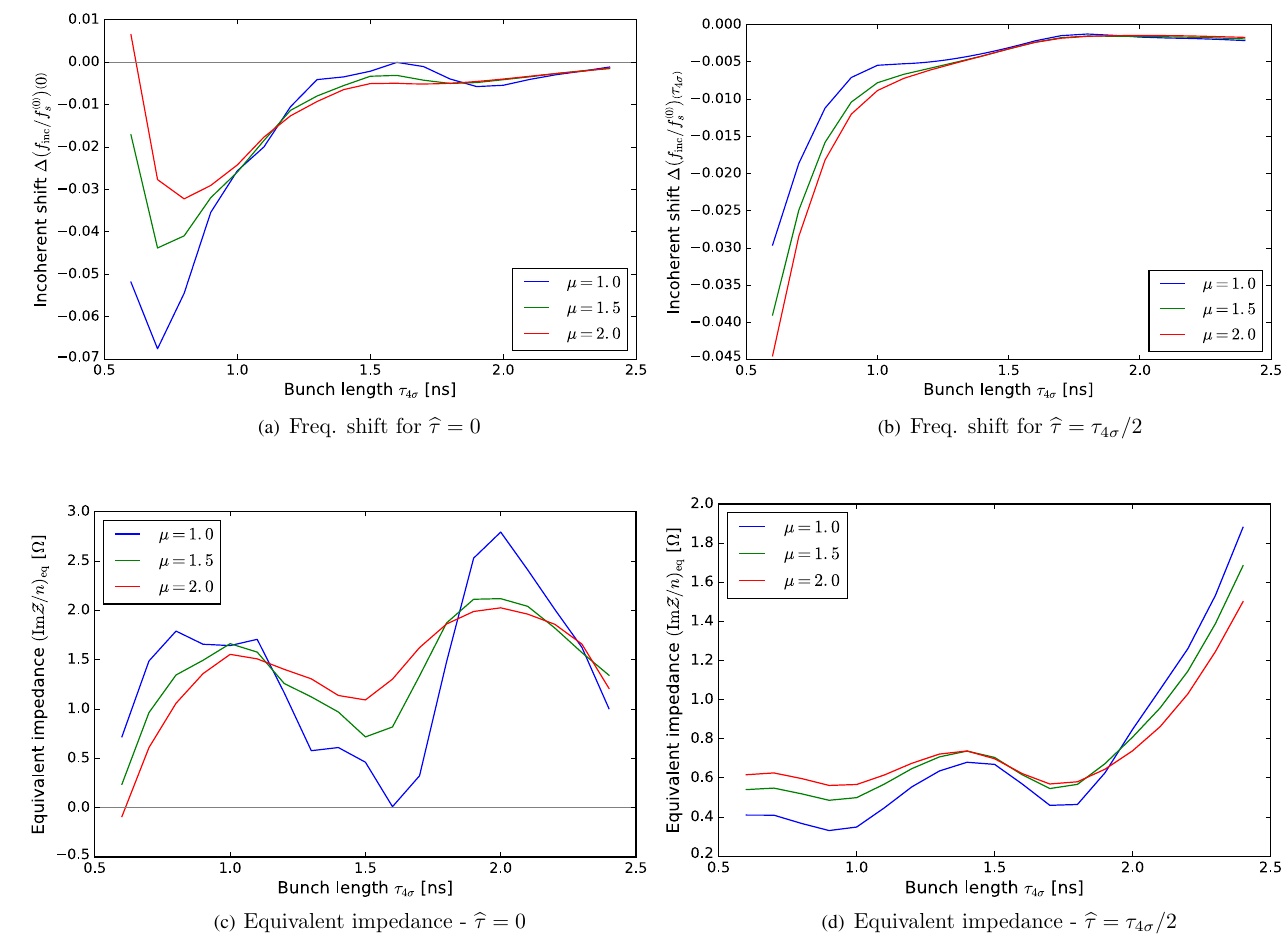
FIG. 8. The incoherent synchrotron frequency shift calculated for particle distributions with different μ as a function of the bunch length τ 4 σ , for the Q26 optics parameters and N b ¼ 5 × 10 10 ppb using the full SPS impedance model. The upper plots correspond to the incoherent frequency shift for small (left) and large (right) particle oscillation amplitudes ˆ τ . The bottom plots (c) and (d) are the equivalent reactive impedances ð Im Z =n Þ corresponding to cases (a) and (b). eq